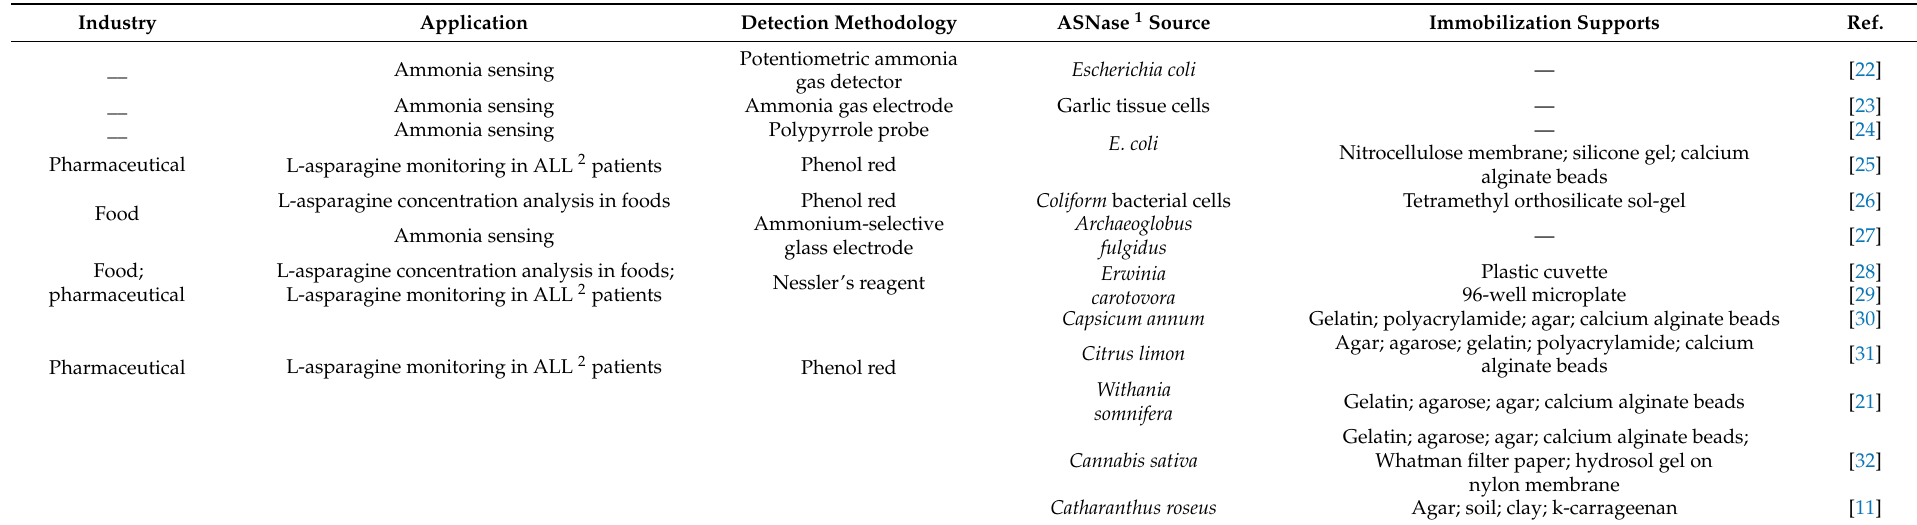
Table 1. Industry, application, detection methodology, ASNase source and immobilization supports of ASNase-based